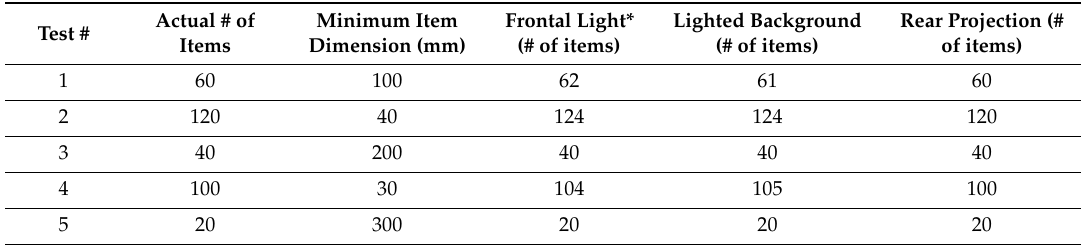
Table 1. The results obtained with the three developed systems for counting the items attached to a galvanic